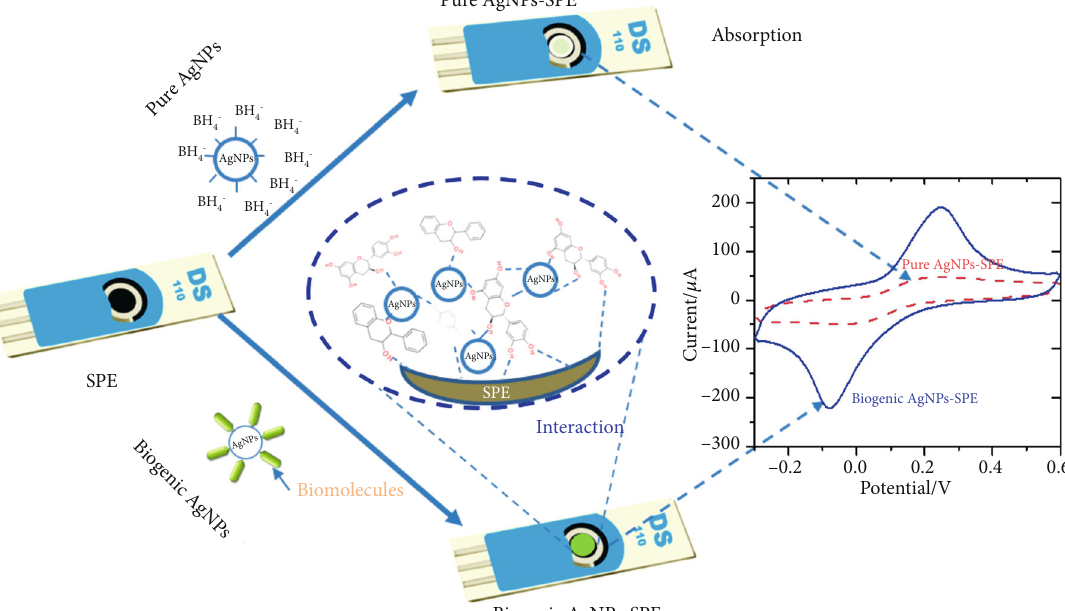
Figure 5: A mechanism for the enhanced electrochemical properties of the biogenic AgNPs deposited on the surface of the SPE compared to the pure